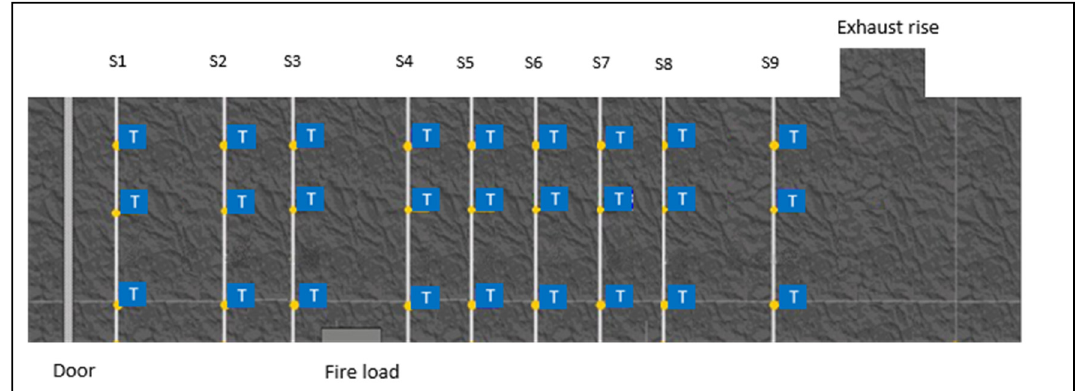
Figure 2. Scheme of the testing drift.